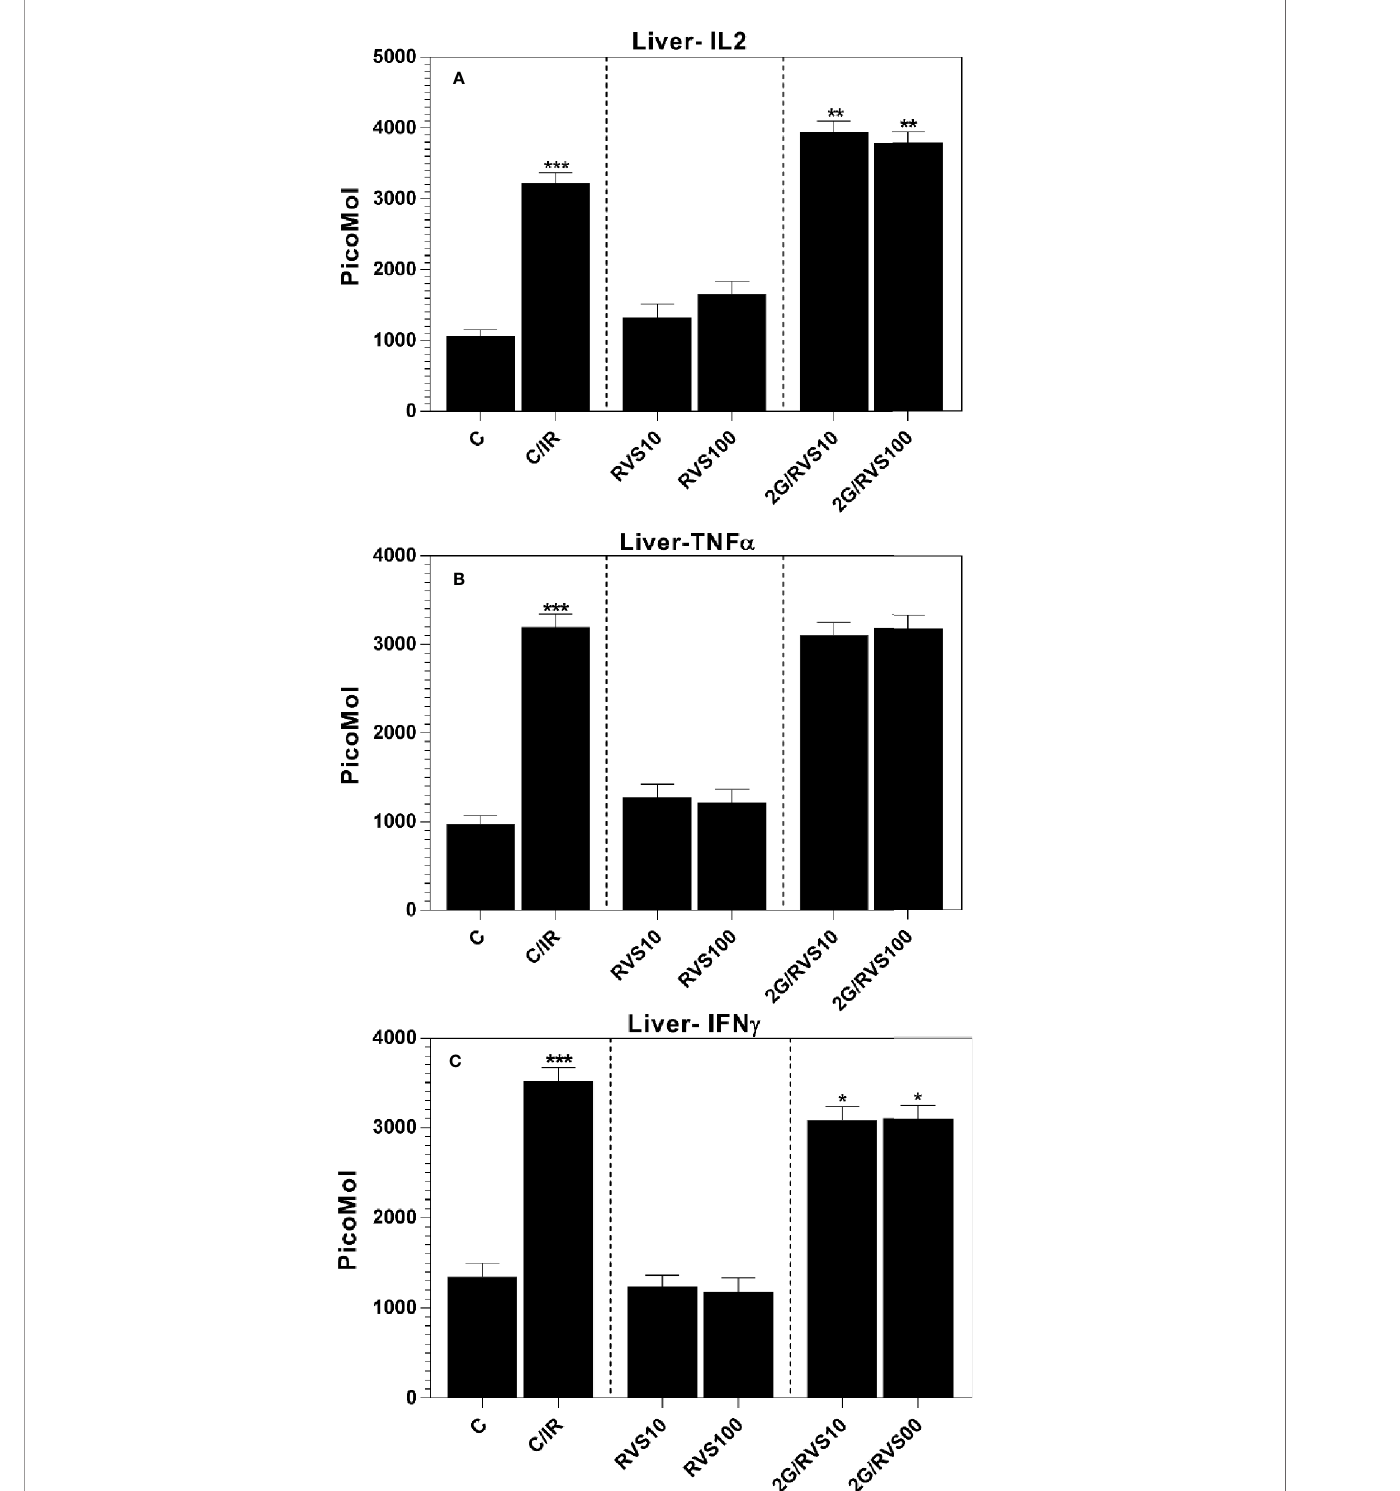
FIGURE 1 | The cytokine pro fi les of Th1 cells measured in total protein extract of Wistar rat liver: (A) IL-2, (B) TNF- a , and (C) INF- g in six rat groups (n = 3). (C, control group; C/IR, irradiated rats, RSV10 and RSV100; irradiated rats with 2 Gy pretreated with resveratrol 10 mg and 100 mg/kg body weight, respectively). C/IR are compared to C; RSV10 or RSV100 are compared to C; 2G/RSV10 or 2G/RSV100 are compared to C/IR. *p < 0.05, **p < 0.01, ***p <